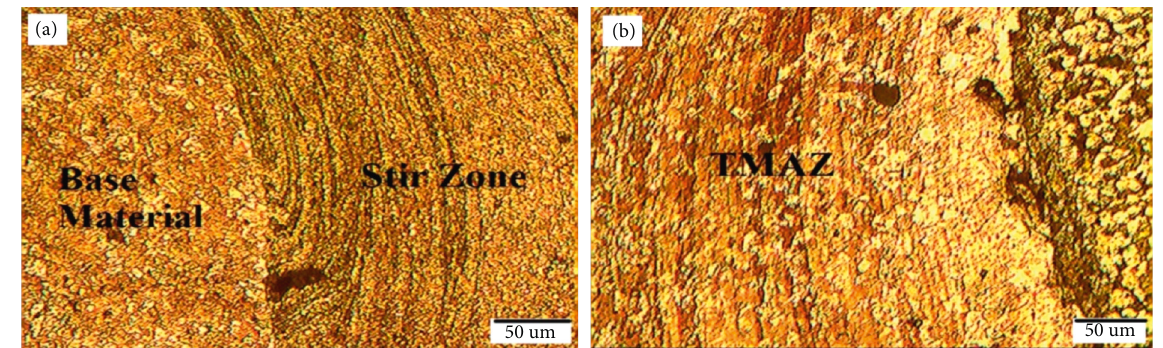
Figure 4: OM image at the rotational speed of 1200rpm (a) Stir zone (b)